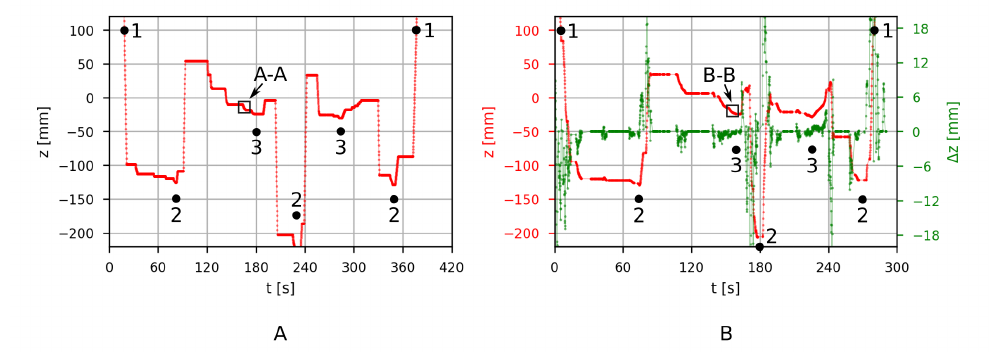
Figure 10. Translation (red) of the robot’s end effector in vertical direction (i.e., Z-axis) ( A ) when the operator is manually controlling the robot with a teach pendant and ( B ) when the operator is manually controlling the robot with the developed IMU system. Input (green) for the robot from the developed IMU system is a change in position ∆ z